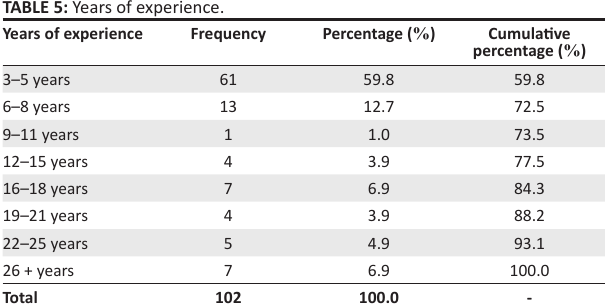
TABLE 5: Years of experience.